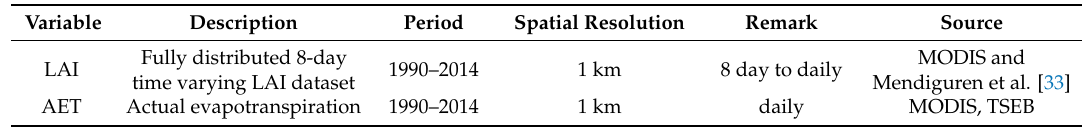
Table 1. Source and resolution details of reference satellite data.